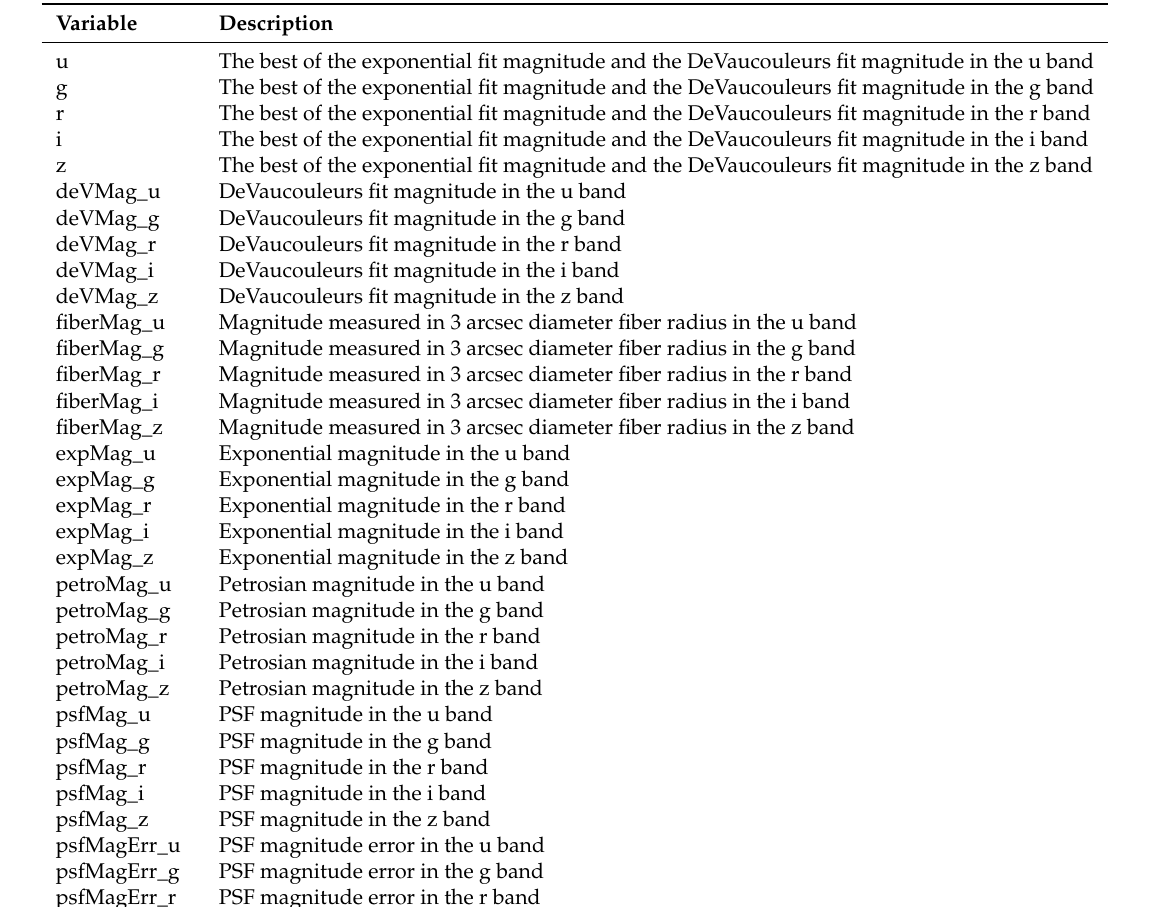
Table A1. Variables used for photometric redshift estimation. The variables used for the photometric redshift are the subset of variables included in the KbestMod feature set, and not the entire set of variables included in the